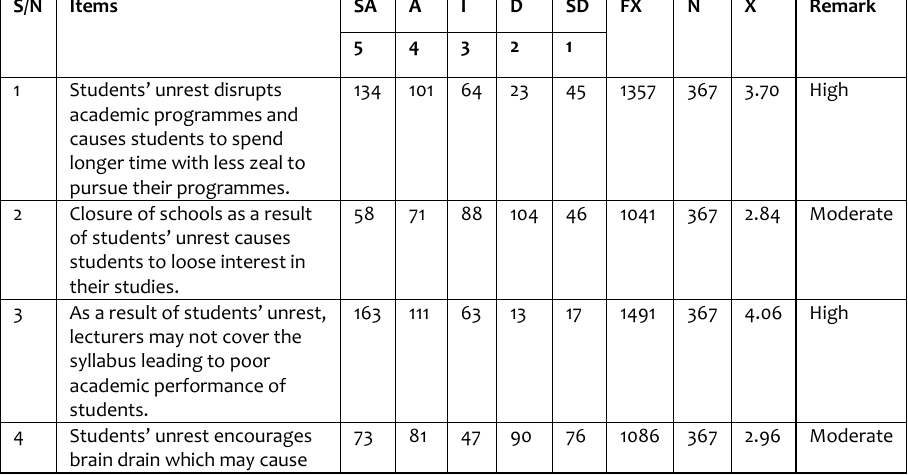
Table 7: Mean calculation of respondents based on implications of students’ unrest on the academic performance of students in institutions of higher learning SA A I D SD S/N